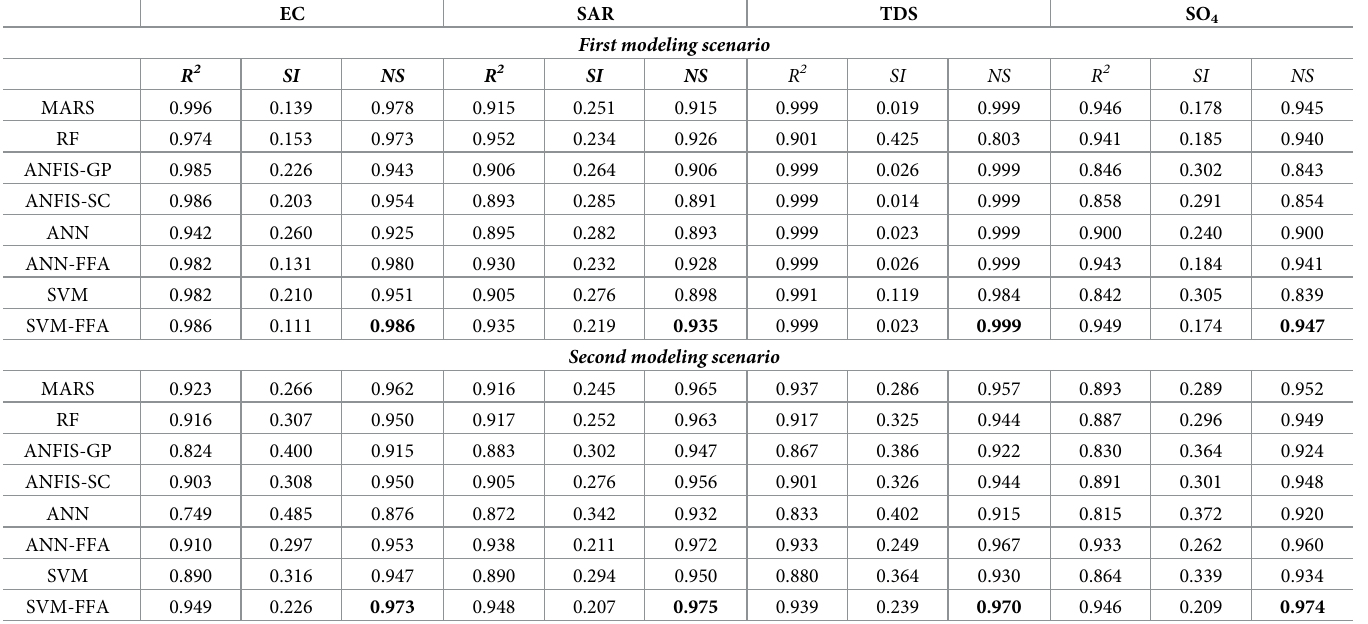
Table 2. Global statistical indices of the applied predictive